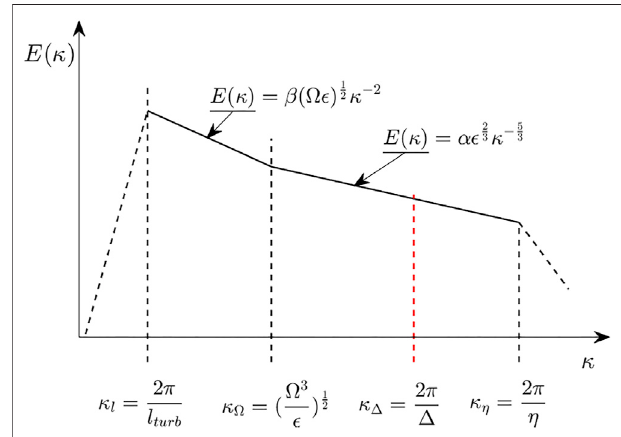
FIGURE 1 | Rotation-corrected energy